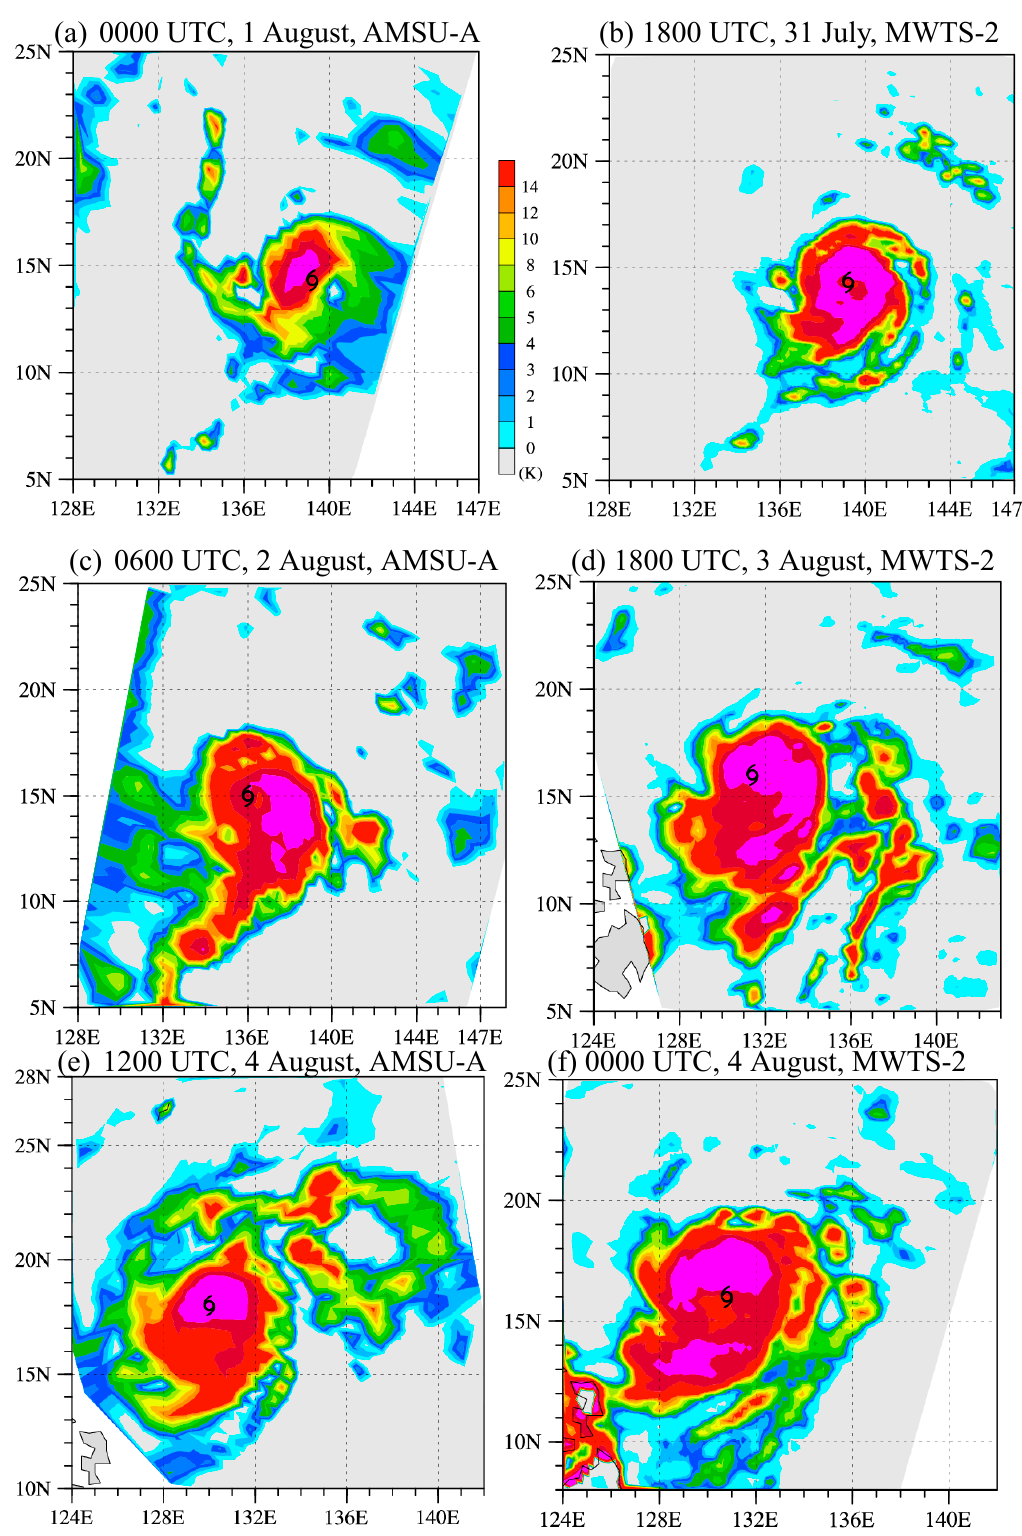
Figure 17. Spatial distributions of ξ O − B for AMSU-A channel 3 around ( a ) 0000 UTC 1August, ( c ) 0600 UTC 2 August, and ( e ) 1200 UTC 4 August, 2014 (left panels), and MWTS-2 channel 1 around ( b ) 1800 UTC 31 July, ( d ) 1800 UTC 3 August, and ( f ) 0000 UTC 4 August, 2014 (right panels).